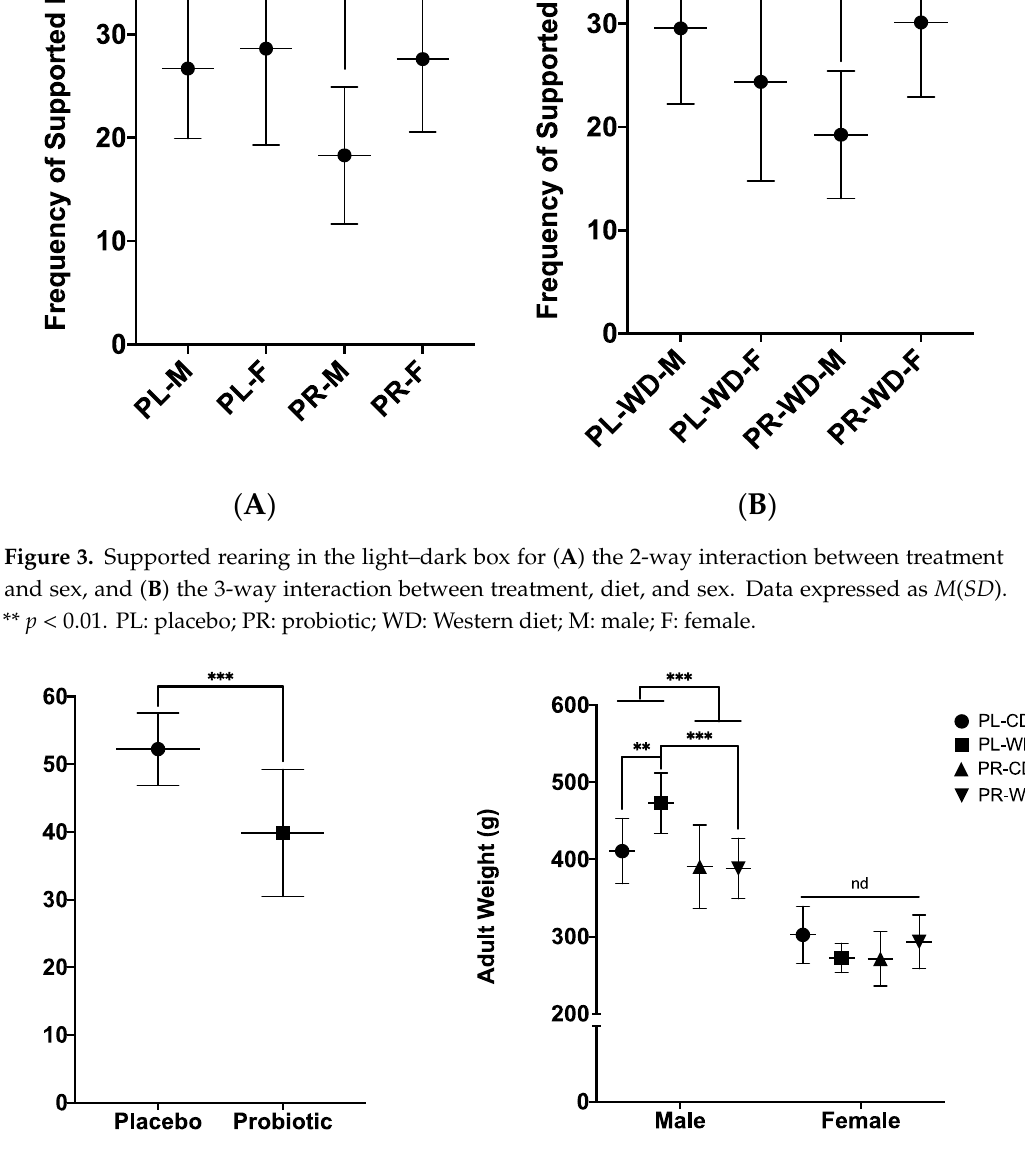
Figure 3. Supported rearing in the light–dark box for ( A ) the 2-way interaction between treatment and sex, and ( B ) the 3-way interaction between treatment, diet, and sex. Data expressed as M ( SD ) . ** p < 0.01. PL: placebo; PR: probiotic; WD: Western diet; M: male; F: female.